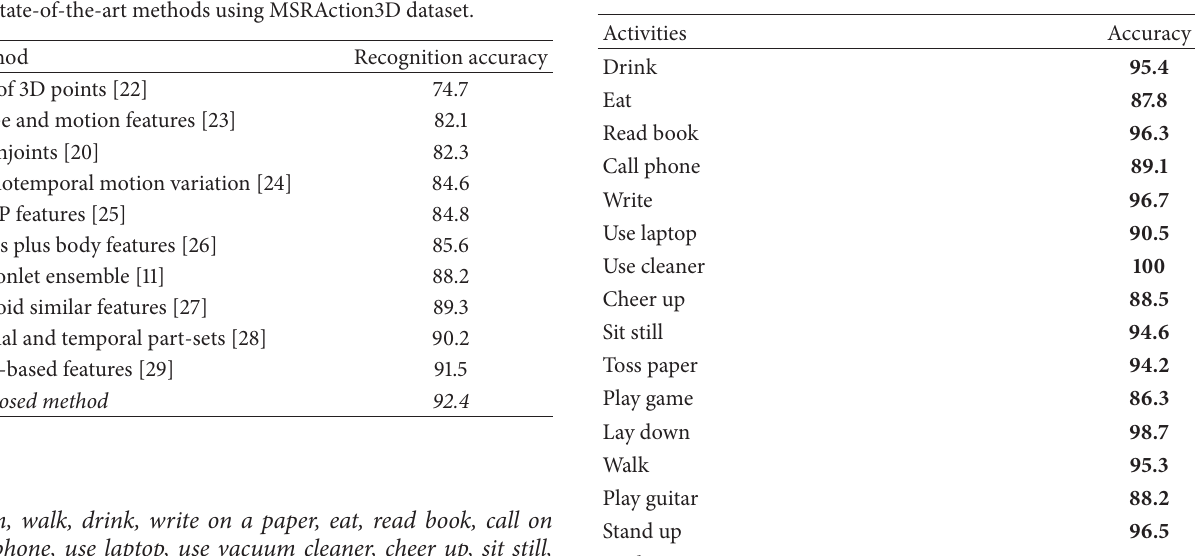
Table 4: Recognition results of proposed HAR system.